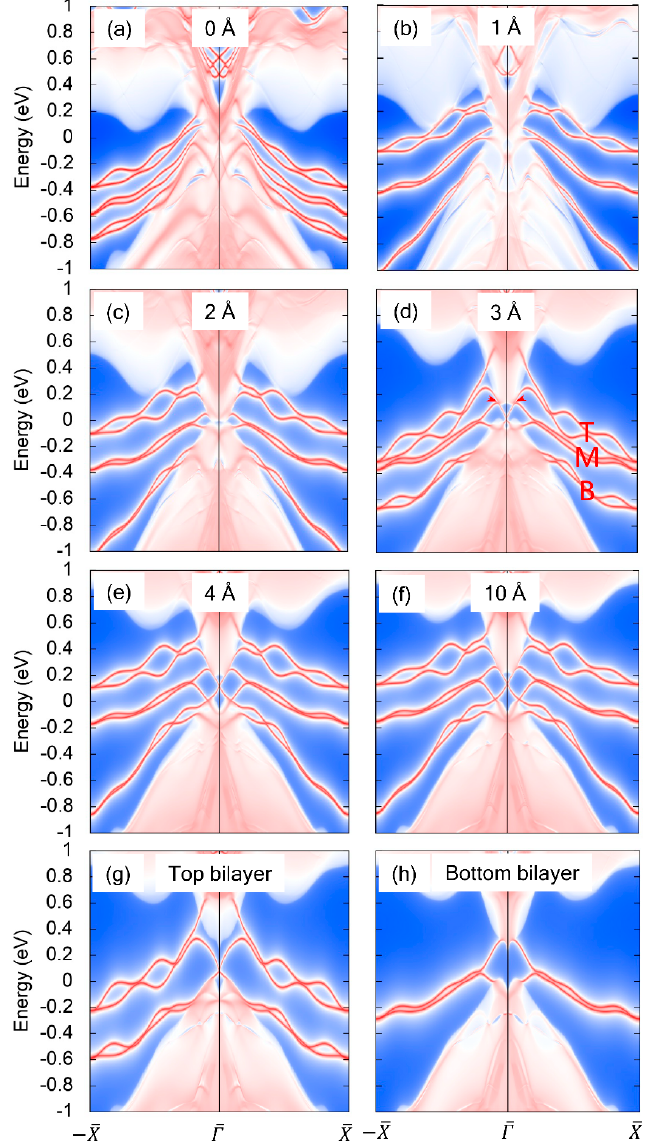
Figure 4. ( a – f ) are the evolution of edge modes along the zigzag edge of a semi-infinite double-bilayer bismuthene with increasing inter-bilayer spacing as indicated. ( g , h ) are the edge modes of individual top bilayer and bottom bilayer of a double-bilayer